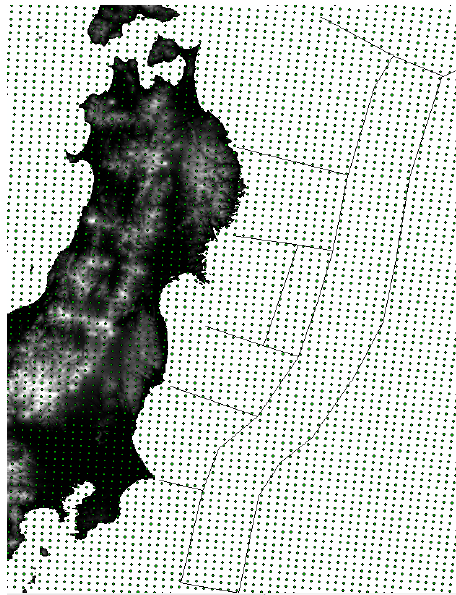
Figure 6. Mesh consisting of 10 km points encompassing the Japan Trench area (black dots).